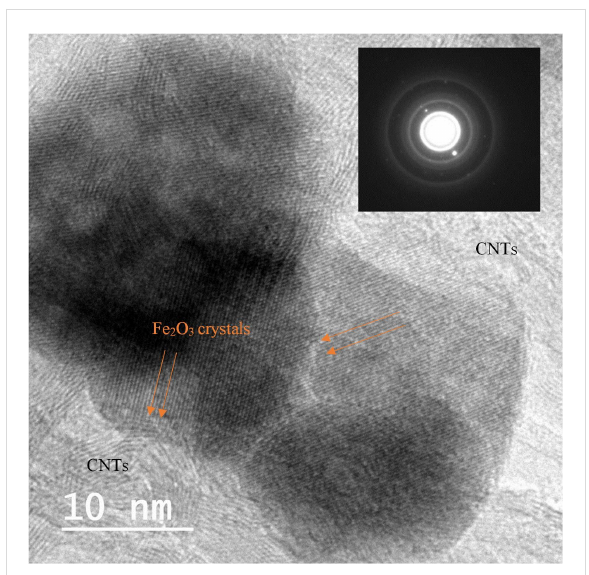
Figure 4: High magnification HRTEM images of MWCNTs decorated with Fe 2 O 3 nanoparticles. The inset shows the electron diffraction pattern (SAED) for the selected